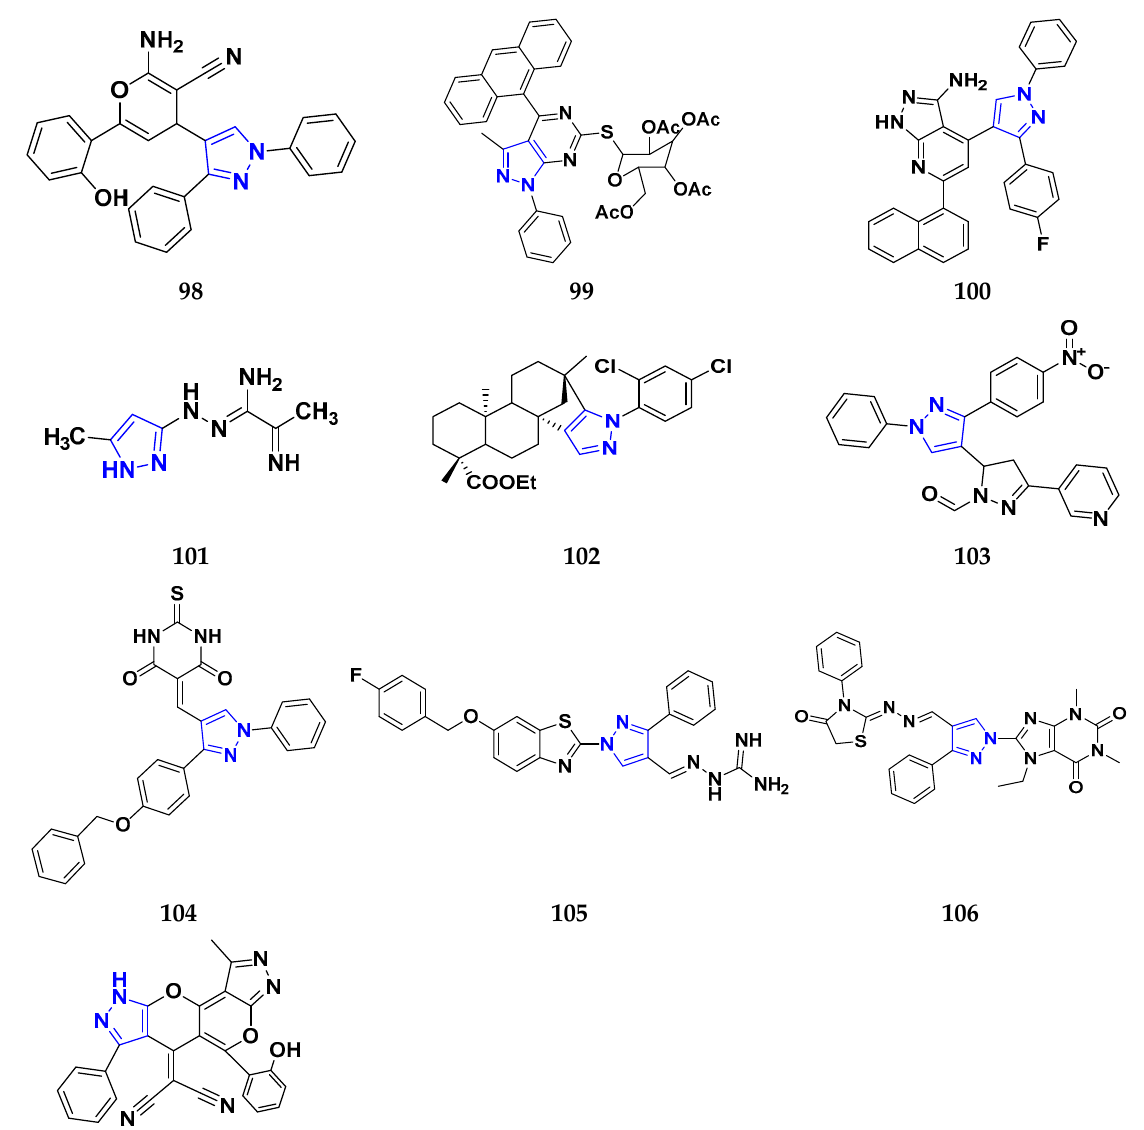
Figure 12. Pyrazole derivatives ( 98 – 107 ) as anticancer agents.